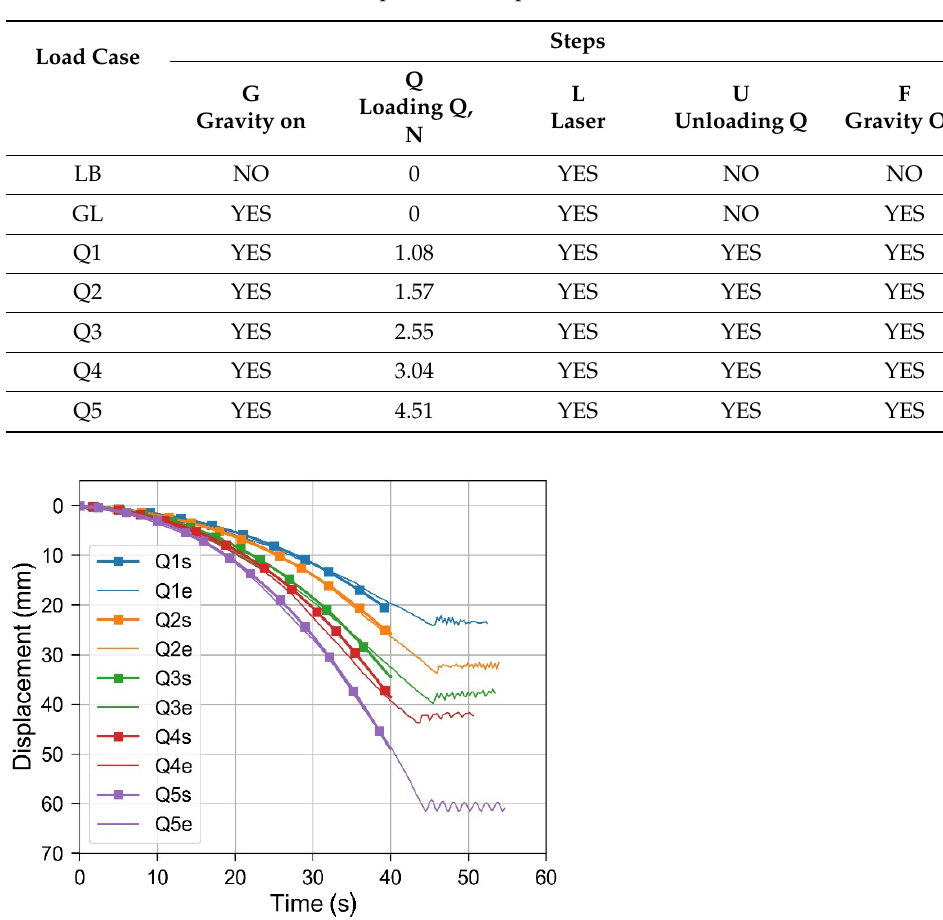
Table 2. List of all load cases and computational steps.